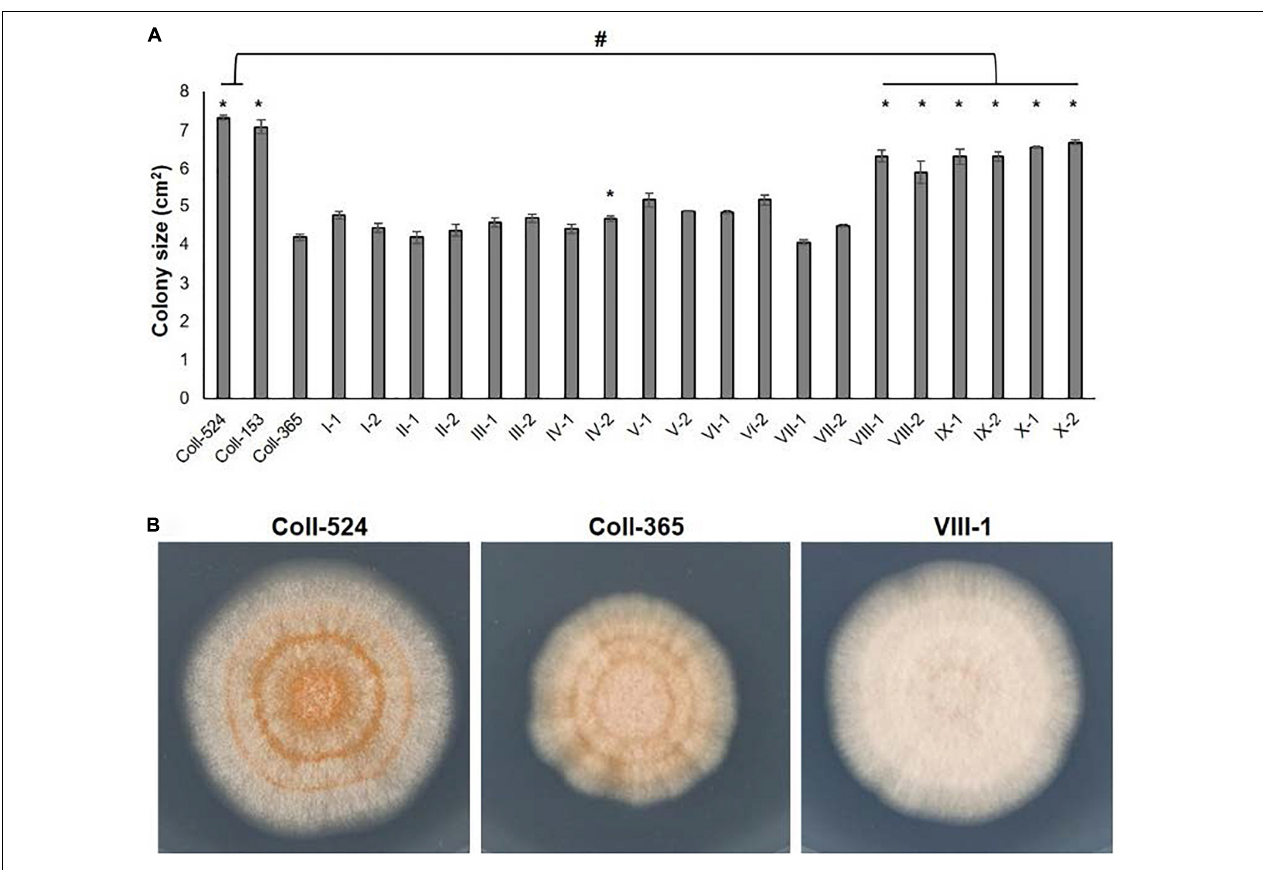
FIGURE 9 | Mycelial growth of strains Coll-524, Coll-153, and Coll-365 and the transgenic strains of Coll-365. (A) Colony size of all assayed strains was presented. When P < 0.5 appeared in two independent experiments after analysis with One-way ANOVA, the significant difference between Coll-365 and other strains was indicated with a star and the significant difference between Coll-524 and six transgenic strains of Coll-365 was indicated with a hash. (B) Colony morphology of strains Coll-524, Coll-365 and VIII-1, a represented colony of strains VIII, IX, and X, on MS agar medium for 5 days at 25 ◦ C under 12 h